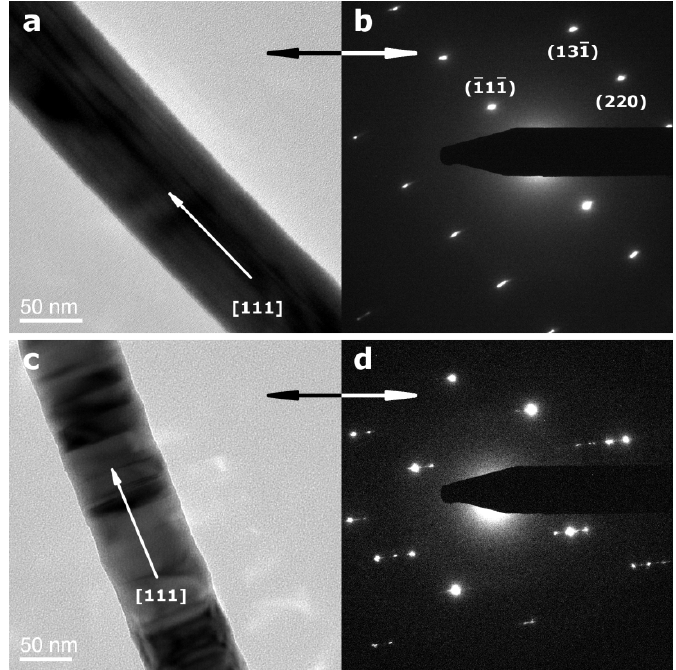
Figure 2. Transmission electron microscopy (TEM) images and selected area electron defraction (SAED) patterns of ZB-type InP nanowires grown at 440 °C ( a , b ) 92 nm diameter InP NWs with less defects and corresponding SAED pattern; ( c , d ) randomly twinned InP NWs with average diameter of 90 nm and SAED pattern of one of such nanowires, which displays the striation of diffraction spots caused by the introduction of random